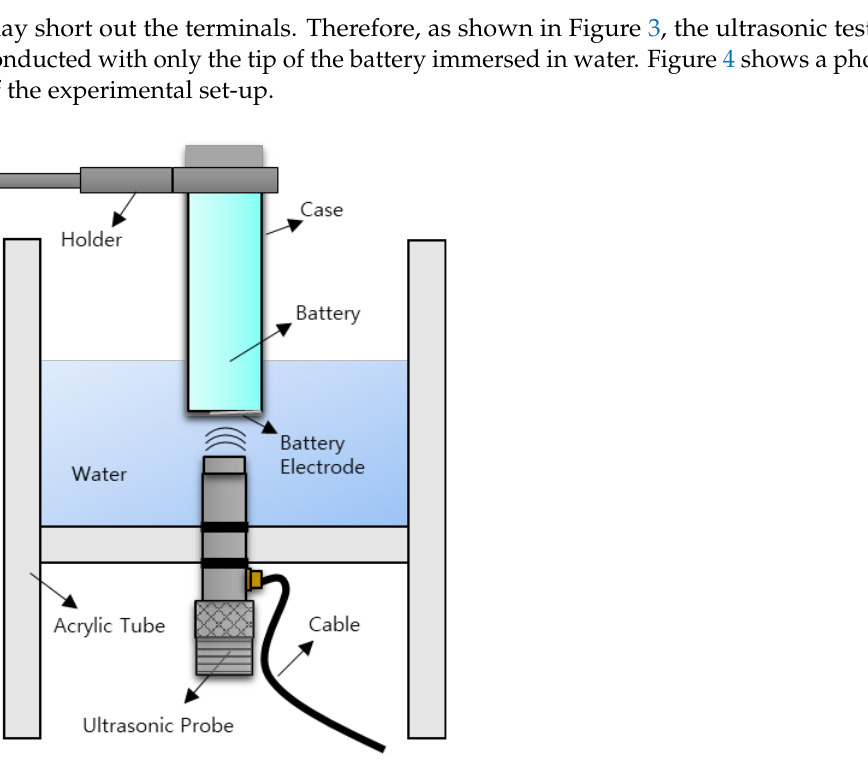
Figure 3. Illustration of the experimental set-up for nondestructive testing of the welding of the battery electrode using a high-frequency ultrasonic probe.